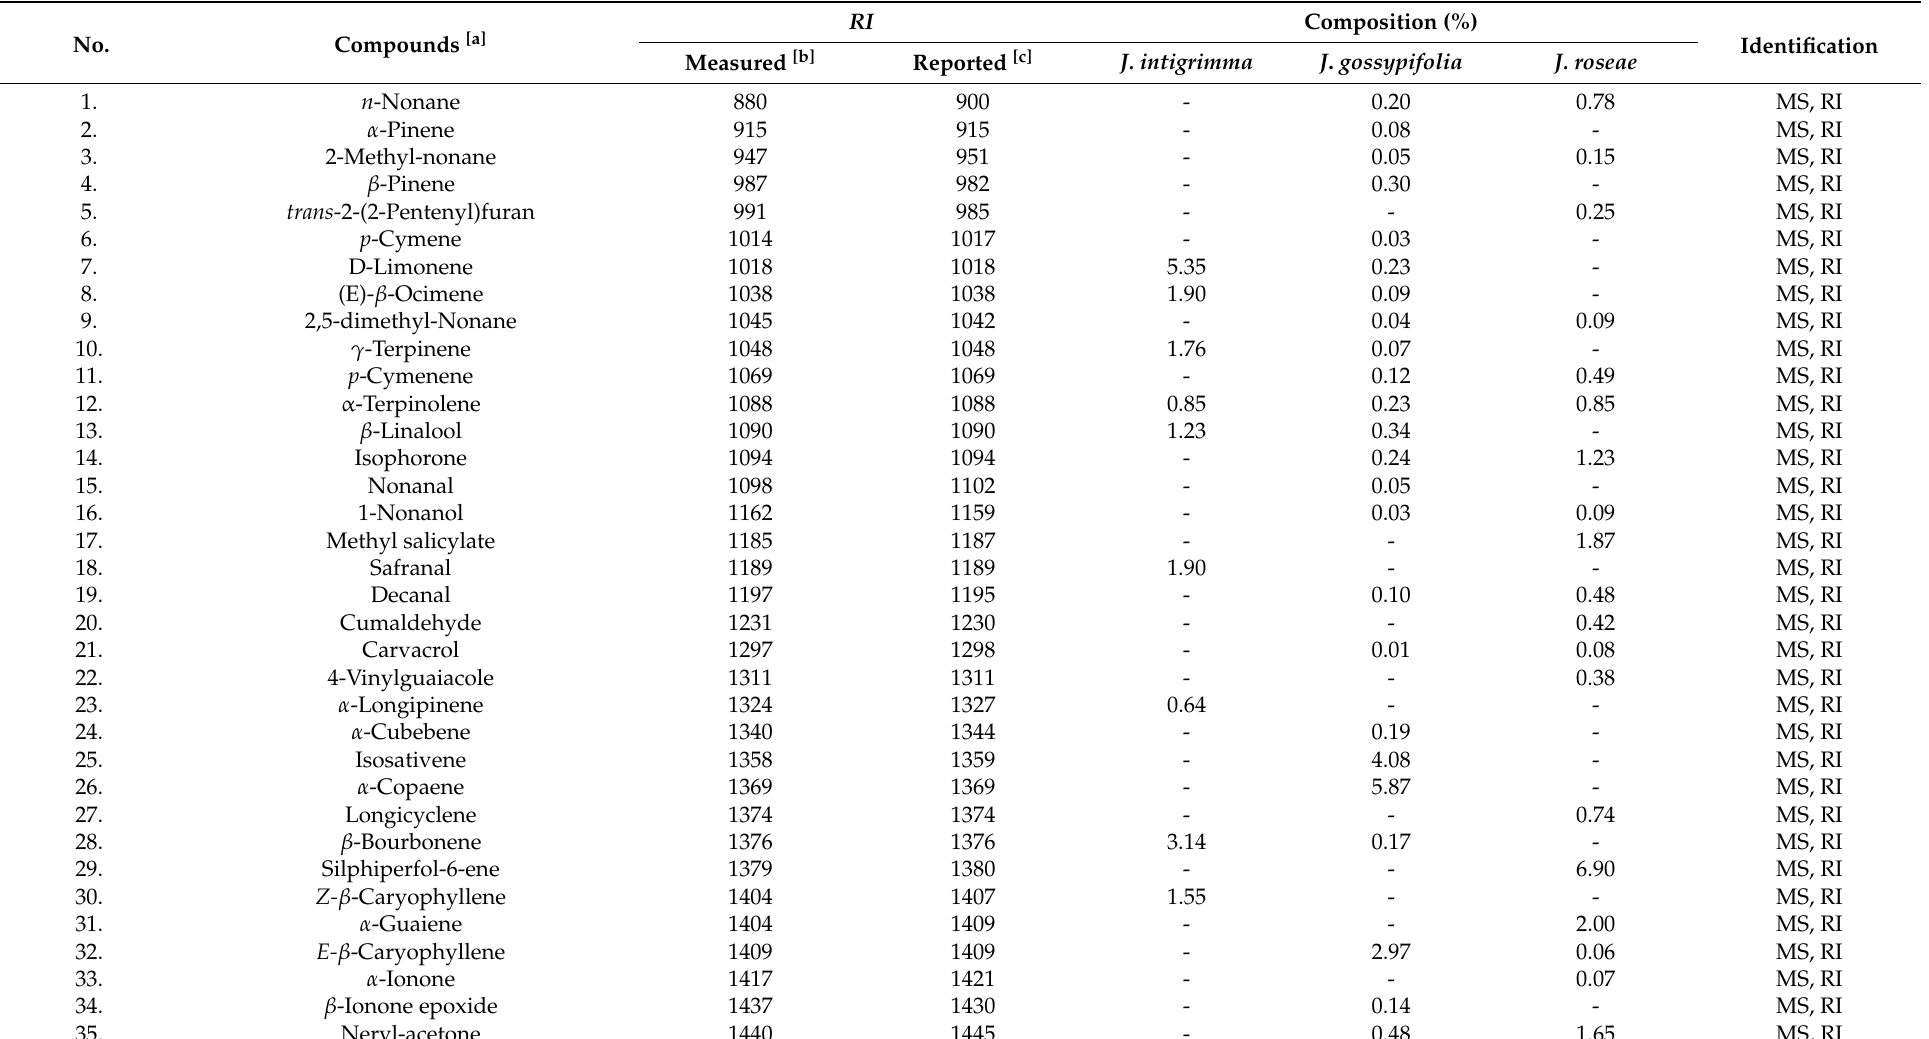
Table 1. Essential oil compositions obtained from J. intigrimma , J. gossypifolia and J. roseae leaves using the Rtx-5MS